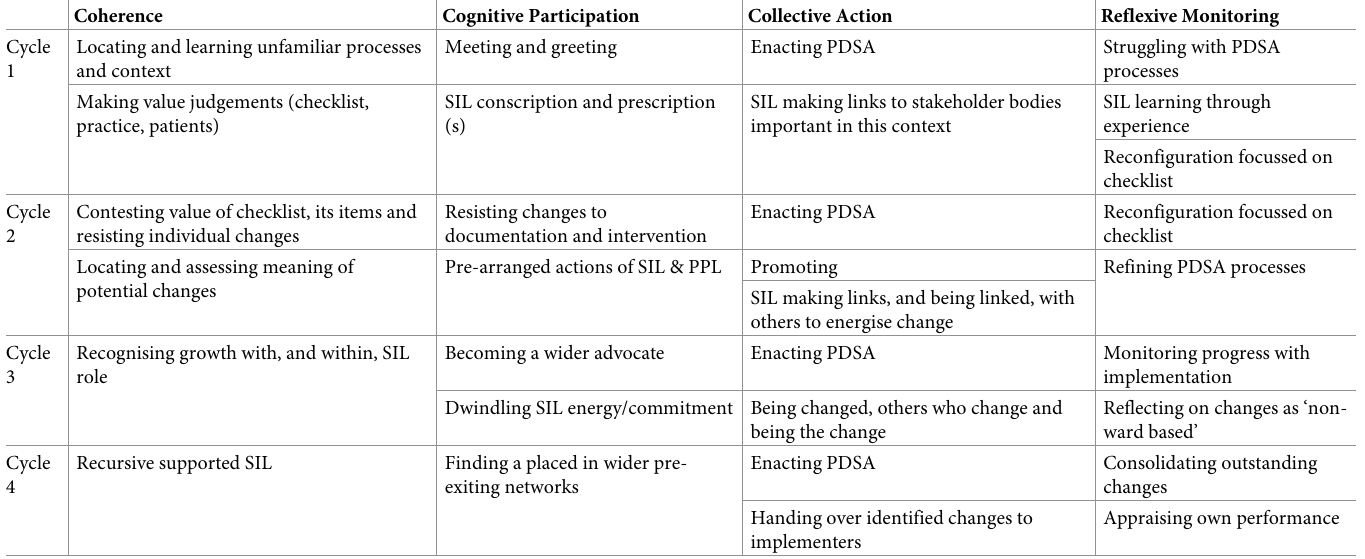
Table 4. Normalisation process at SITE